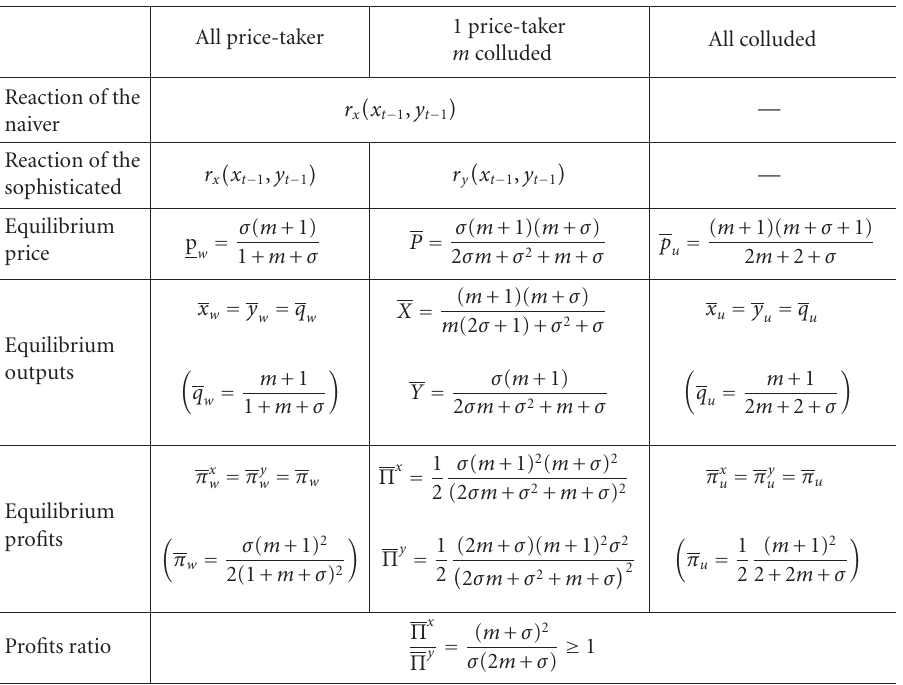
Table 3.1. Equilibrium